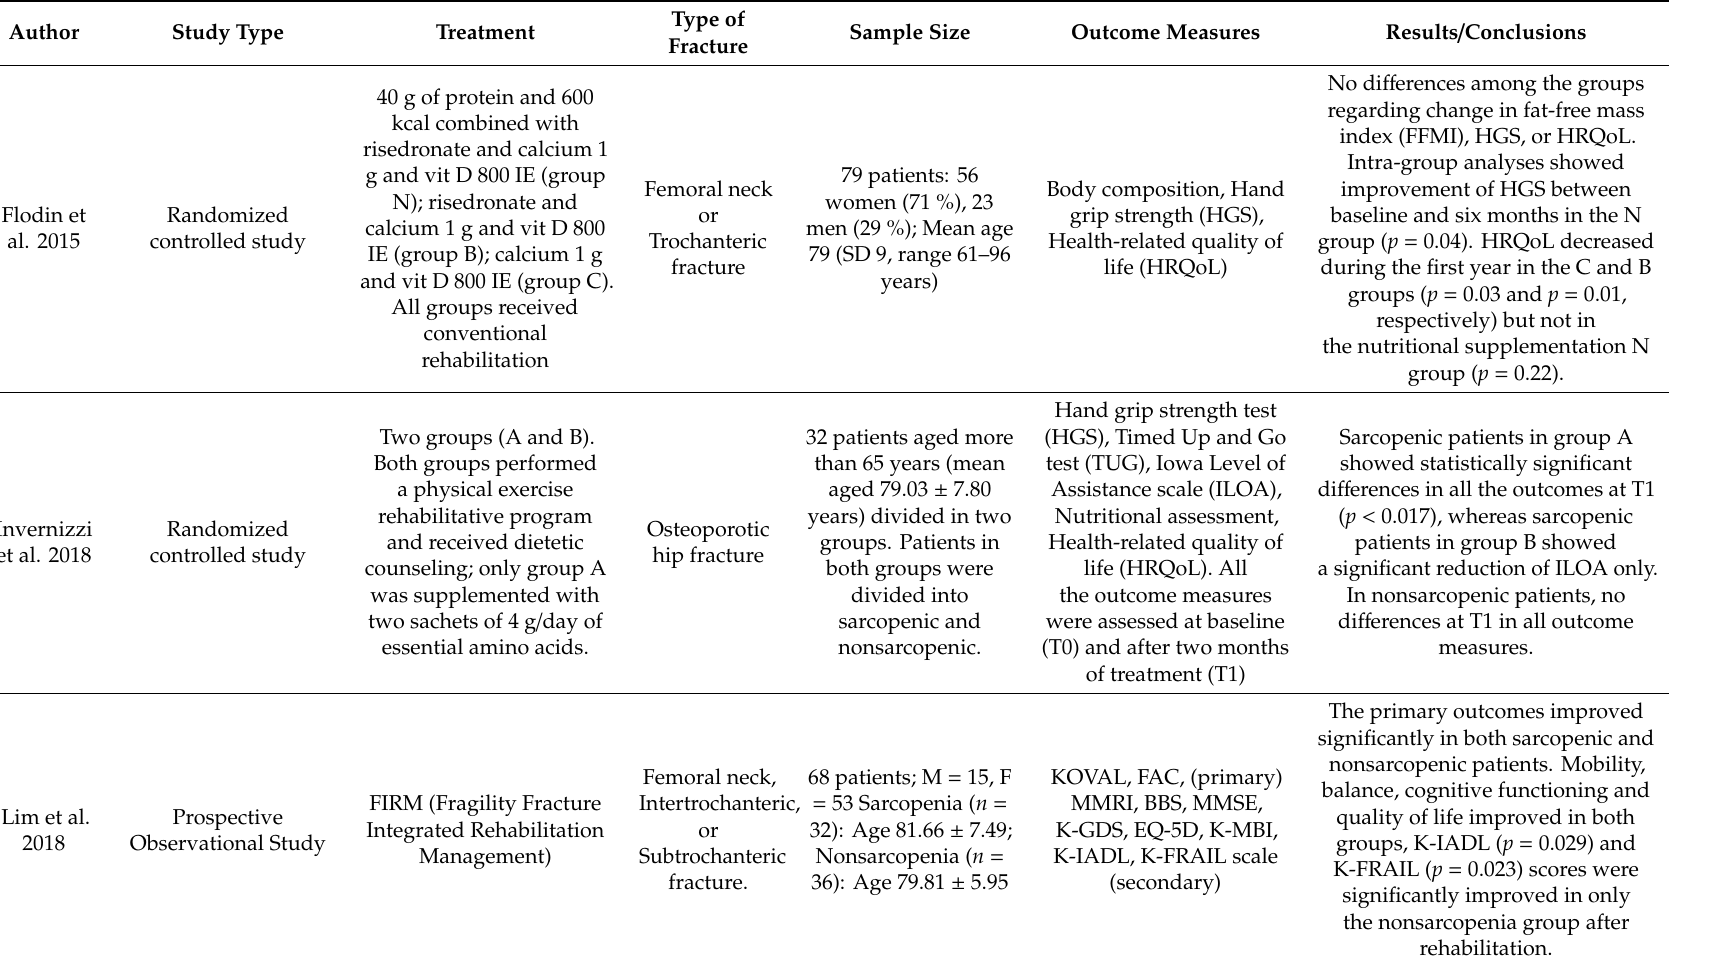
Table 1. Characteristics of examined